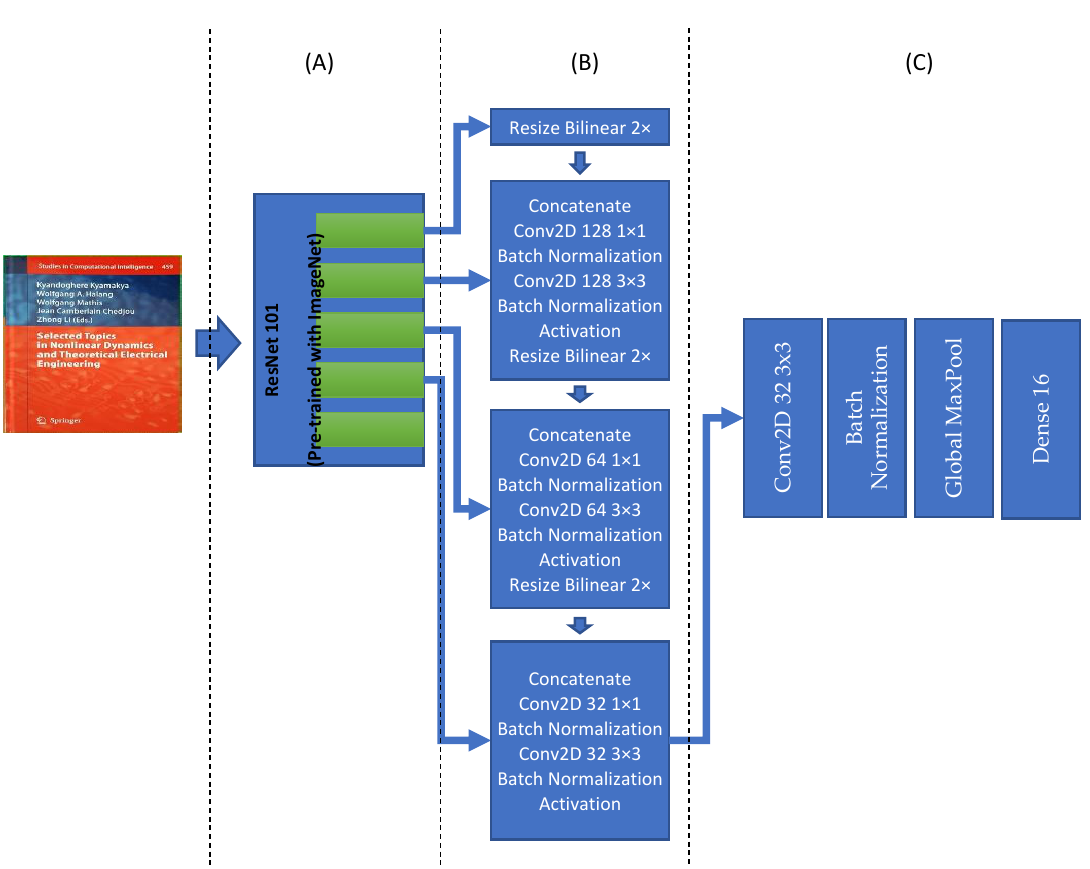
Figure 10. Model IV, it is containing three sections: ( a ) Feature extraction based on ResNet101; ( b ) Feature extraction layers; ( c ) Output layer.